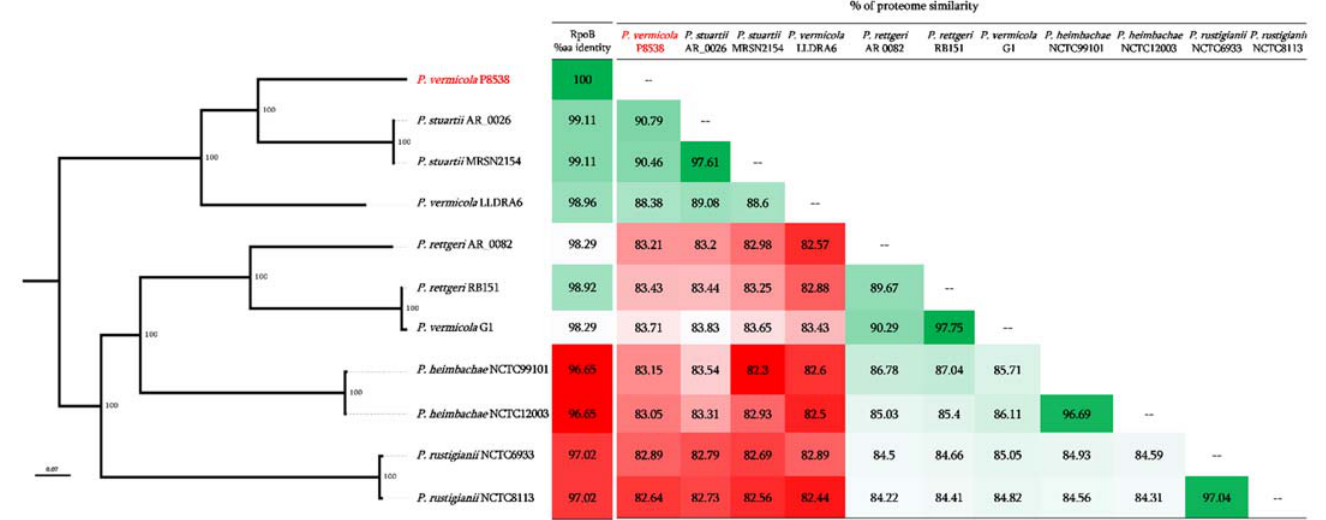
Figure 2. Comparison of the P. vermicola pPV8538_NMD-1 plasmid with E. coli pEC8540 plasmid and the three closest plasmids retrieved from the NCBI database.